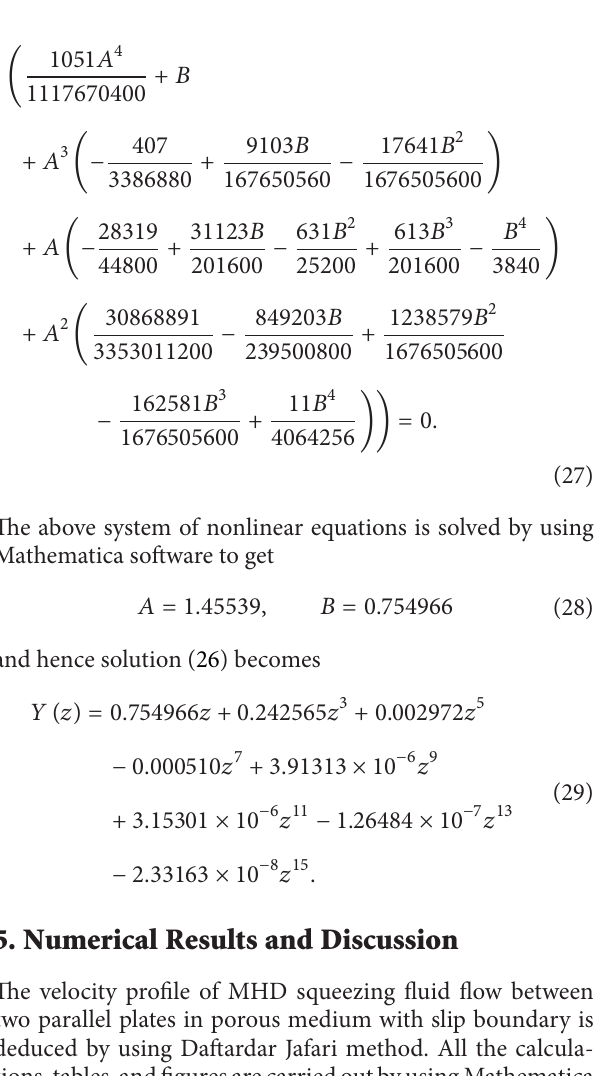
Figure 3: Velocity profile for different values of slip parameter and Reynold and Hartmann numbers with Re ≥ Me.